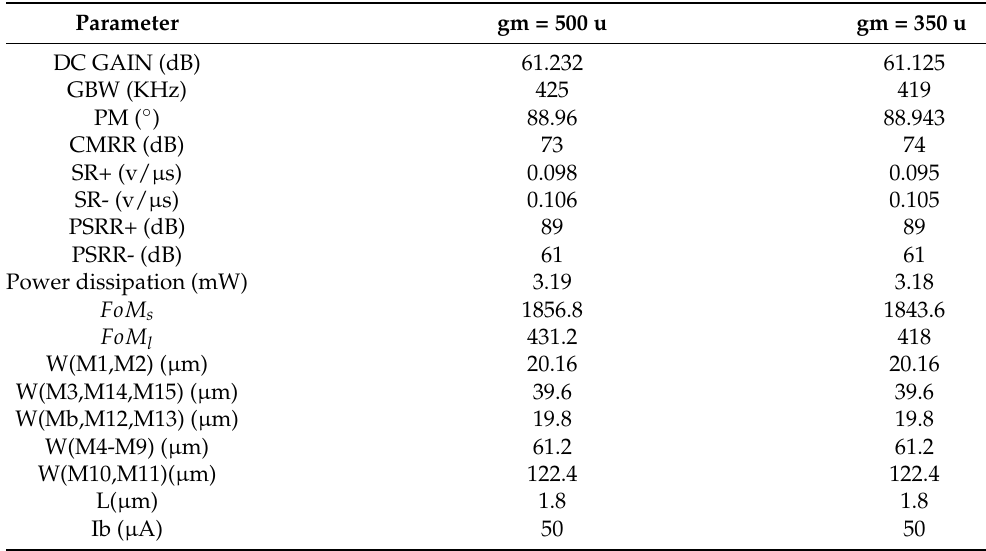
Table 1. Electrical characteristics and sizes of the CMOS OTA shown in Figure 10 to provide a gm = 500 µ A/V and gm = 350 µ